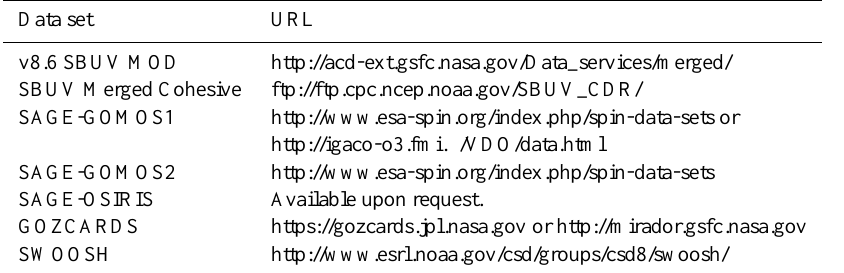
Table 7. URLs for each of the seven data sets. Data